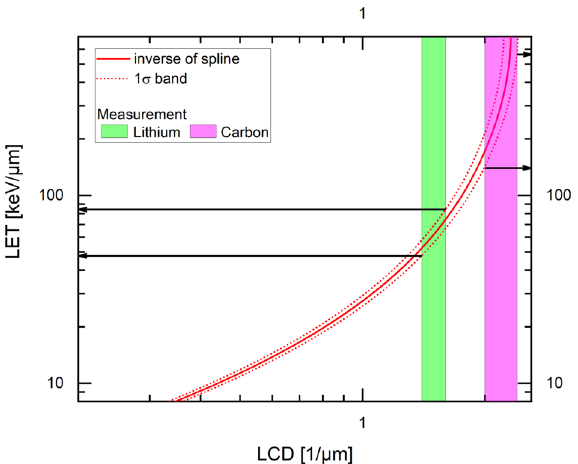
Figure 6. Inverted spline curve of LET for dosimetry. The values of LID for lithium (green) and carbon ion (magenta) irradiation are added as boxes to be able to determine LET (from the intersection of box and